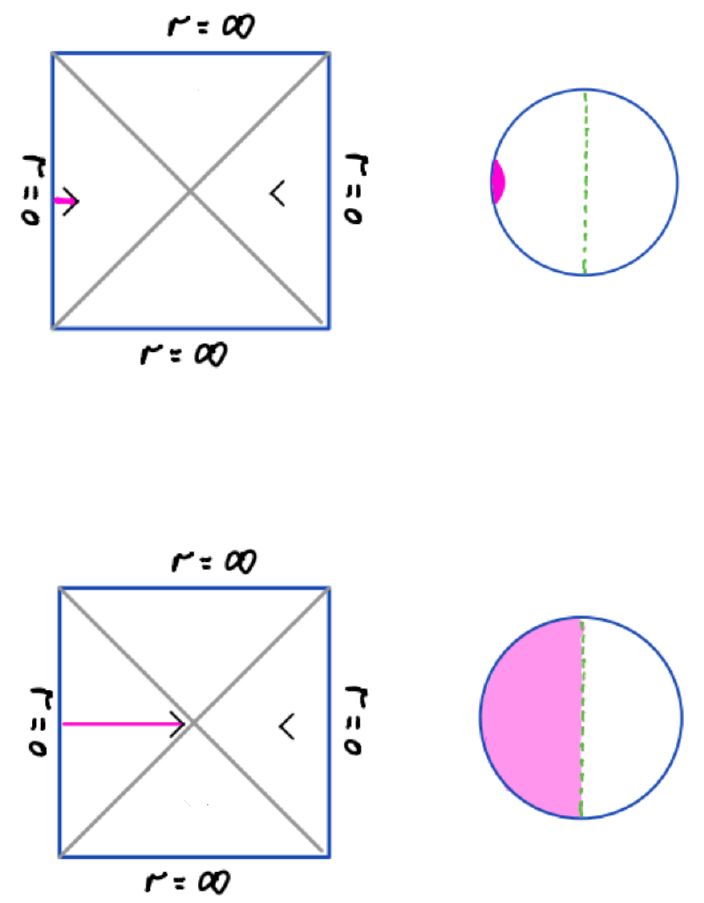
Figure 7. Penrose–Bousso diagrams for de Sitter space. In the upper panel, the screen is near the pode and the screen has almost no degrees of freedom. In the lower panel, the screen is near the horizon and the number of degrees of freedom is sufficient to encode the entire static patch.